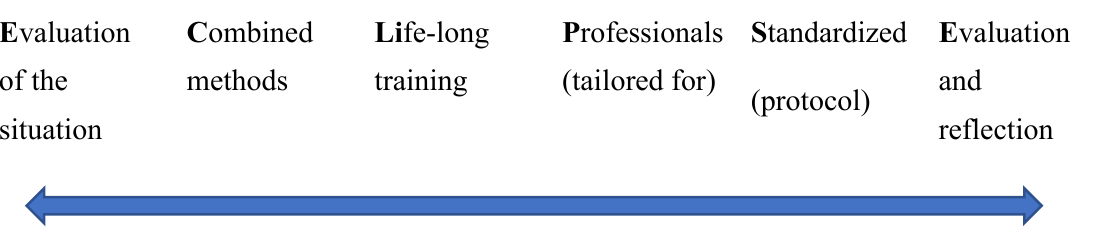
Figure 2. The ECLiPSE pathway for effective training of nurses in handling elder abuse cases.